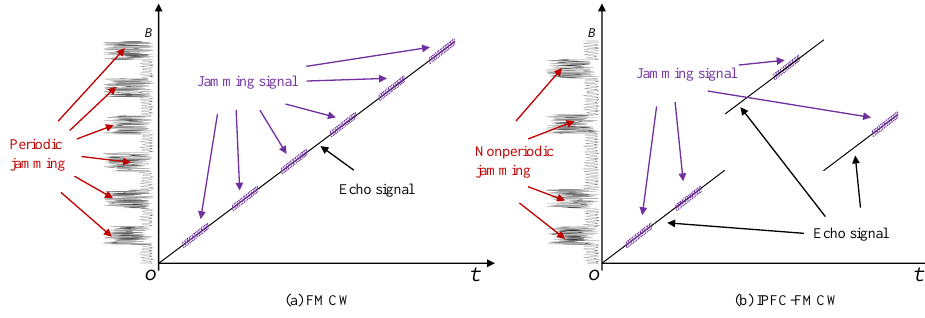
Figure 6. Comparison of two waveforms with smart noise jamming.